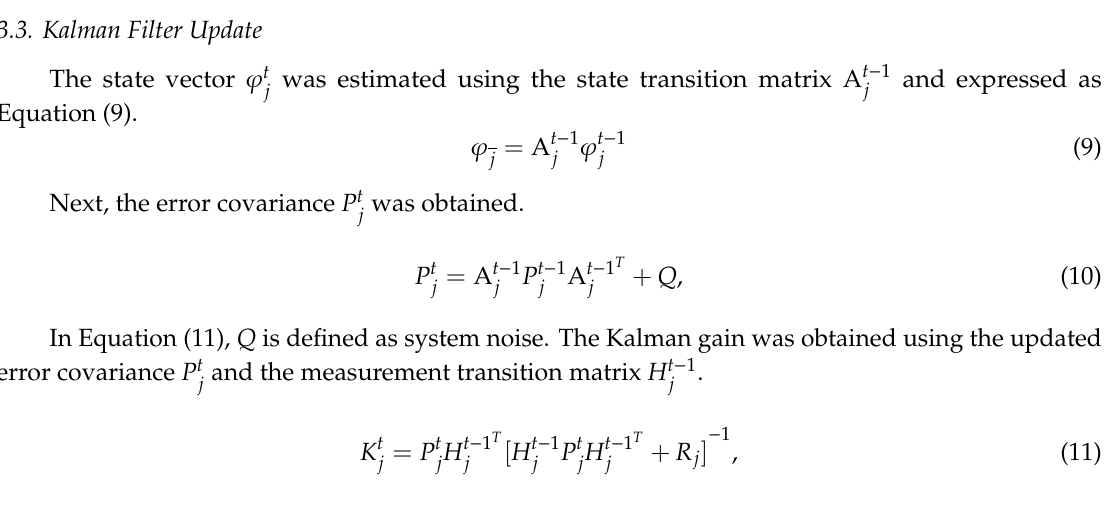
Figure 9. Differentiation result of the reliability function according to parameter change: when X lidar , reli = 25, X radar , reli = 50, ( a ) α = 0.1, β = 1 and α = 0.1, β = 0.5; ( b ) α = 1, β = 1 and α = 1, β = 0.5; 𝑋 (cid:3039)(cid:3036)(cid:3031)(cid:3028)(cid:3045),(cid:3045)(cid:3032)(cid:3039)(cid:3036) = 25 , 𝑋 (cid:3045)(cid:3028)(cid:3031)(cid:3028)(cid:3045),(cid:3045)(cid:3032)(cid:3039)(cid:3036) = 50, (a) 𝛼 = 0.1, 𝛽 = 1 and 𝛼 = 0.1, 𝛽 = 0.5; (b) 𝛼 = 1, 𝛽 = 1 and 𝛼 = 1, ( c ) α = 1, β = − 1 and α = 1, β = − 𝛽 = 0.5; (c) 𝛼 = 1, 𝛽 = − 1 and 𝛼 = 1, 𝛽 = − 0.5.